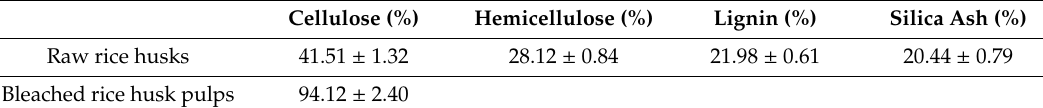
Table 3. Chemical composition of raw rice husks and bleached rice husk pulps.